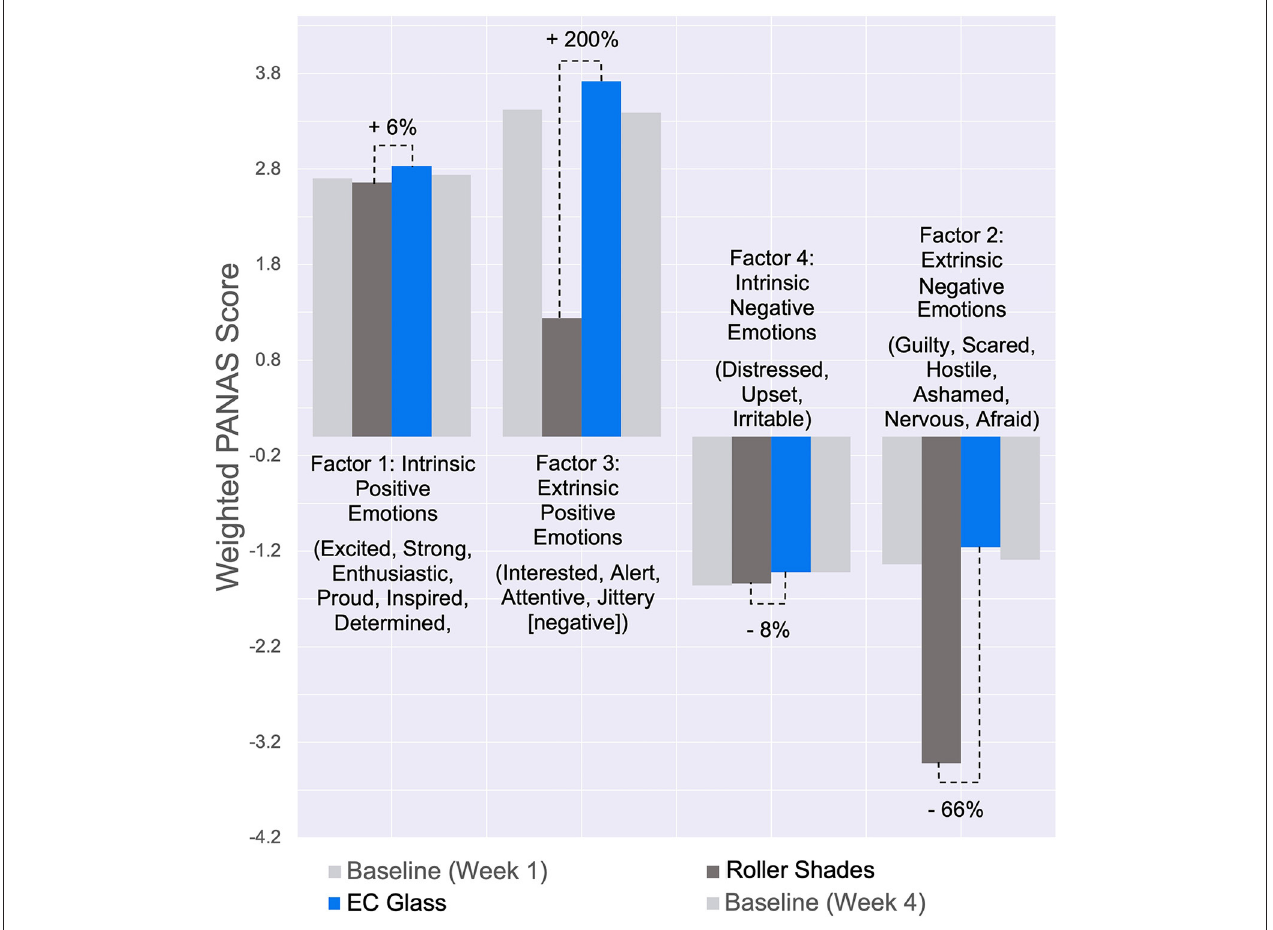
FIGURE 6 | Weighted PANAS scores across the four study weeks, grouped by factors identified in the PANAS item factor